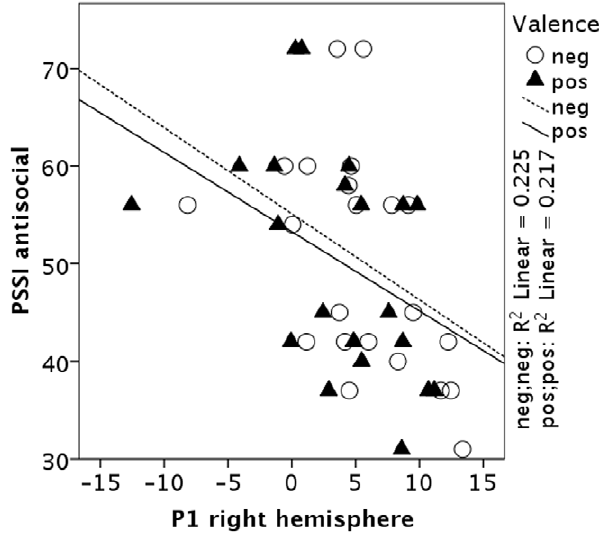
Figure 2. Scatter plot of AS-subscale scores and P1 amplitudes at right-hemispherical electrode locations for happy (triangles) and angry (circles) facial feedback stimuli.